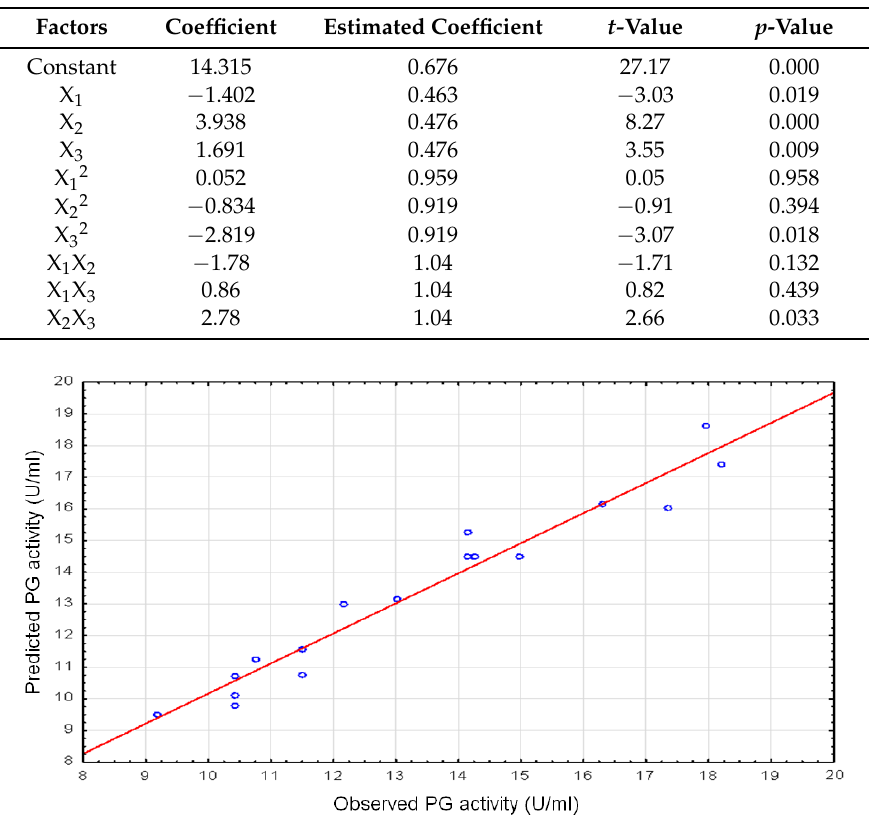
Table 7. Results of regression analysis of the second-order polynomial model for optimization of potentiation of PG activity.